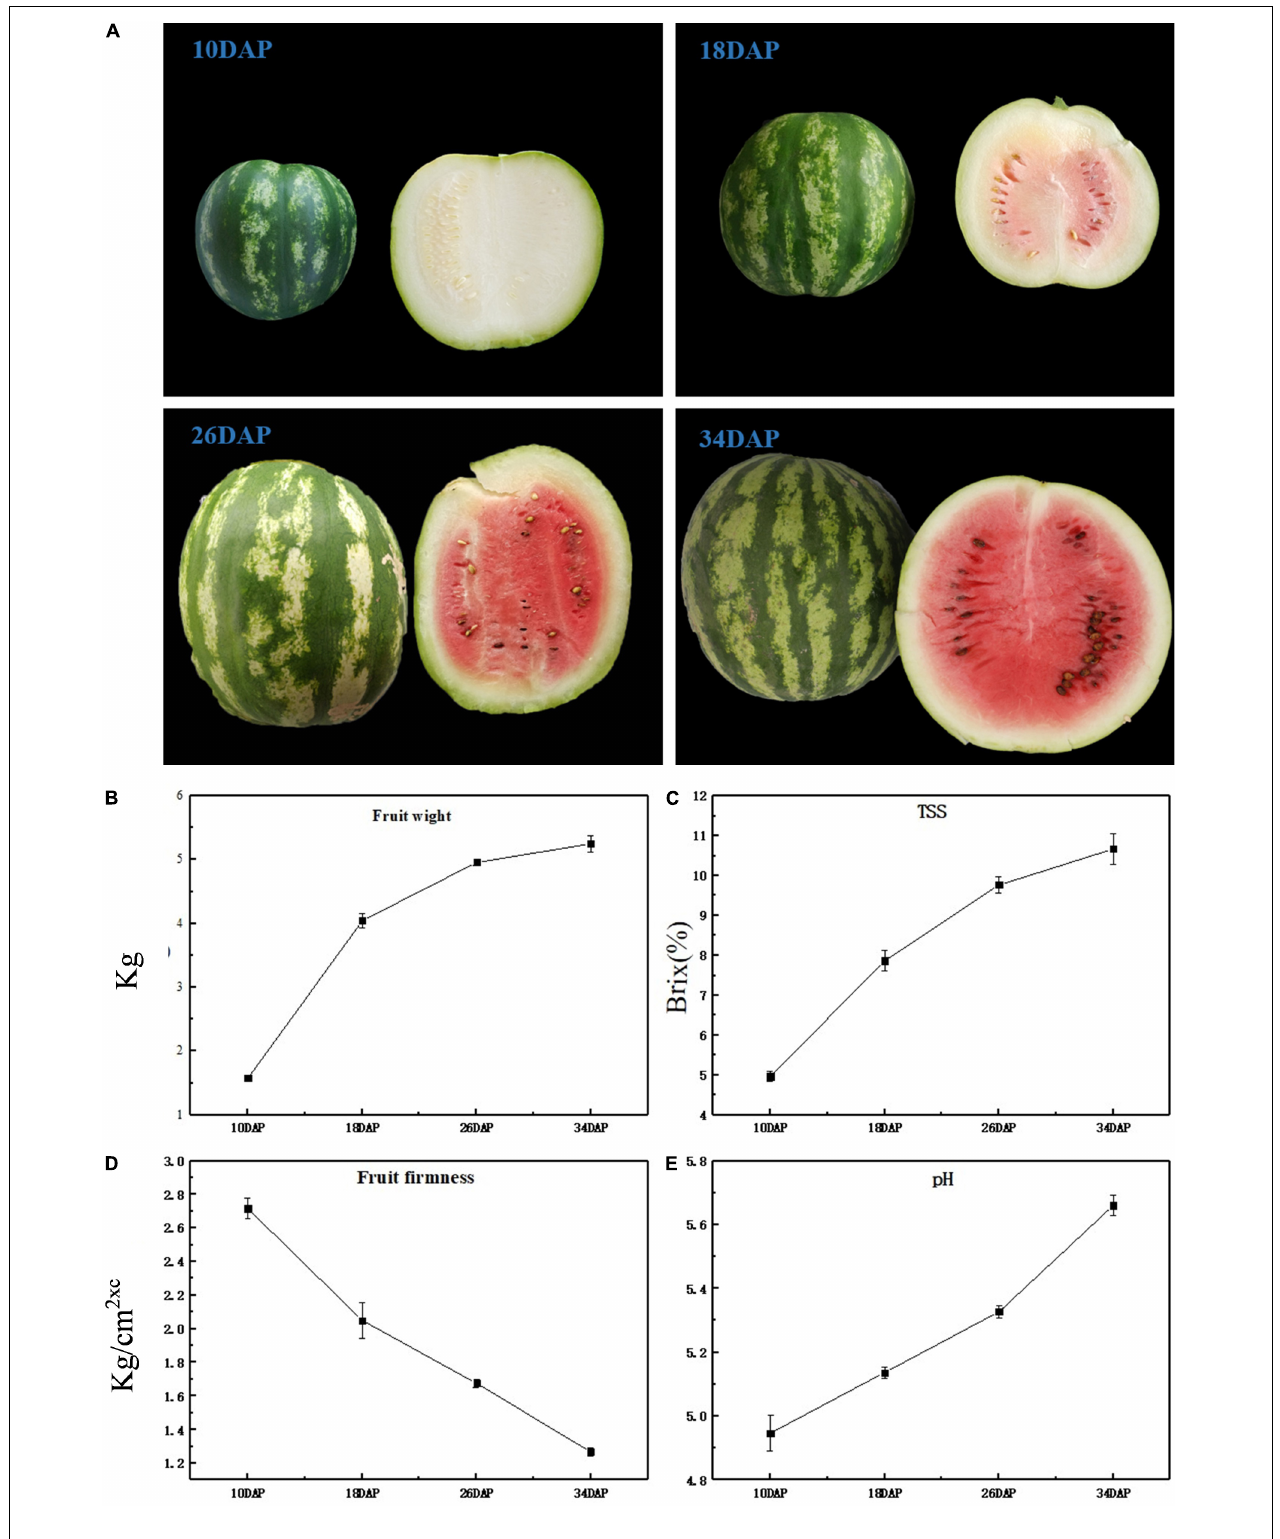
FIGURE 1 | Physiological characteristics of ‘Crimson’ watermelon fruit. (A) The appearance of ‘Crimson’ at four key development stages (10, 18, 26, and 34 DAP). (B–E) Fruit weight, TSS content (Brix%), flesh firmness, and pH during different development stages of ‘Crimson’ watermelon fruit, respectively. And each stage of these four agronomic traits took three biological